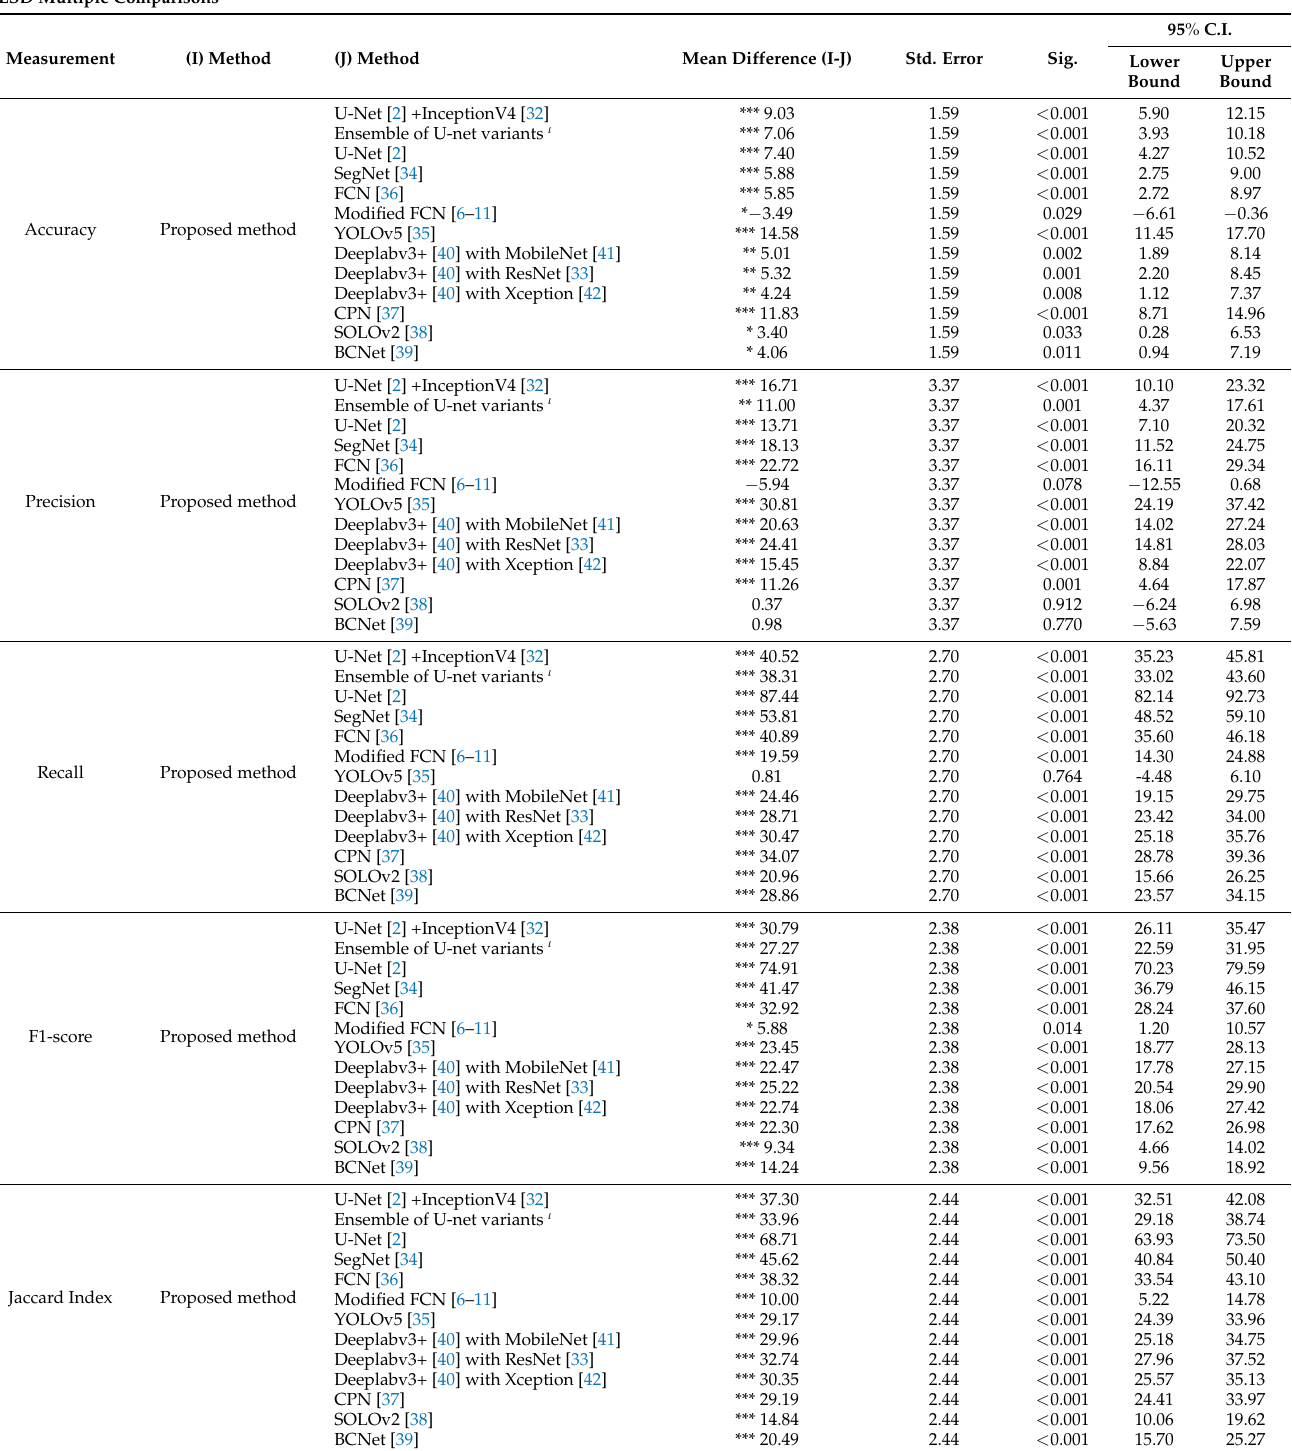
Table 4. Statistical analysis to compare the proposed method with benchmark approaches using the LSD test on DISH dataset